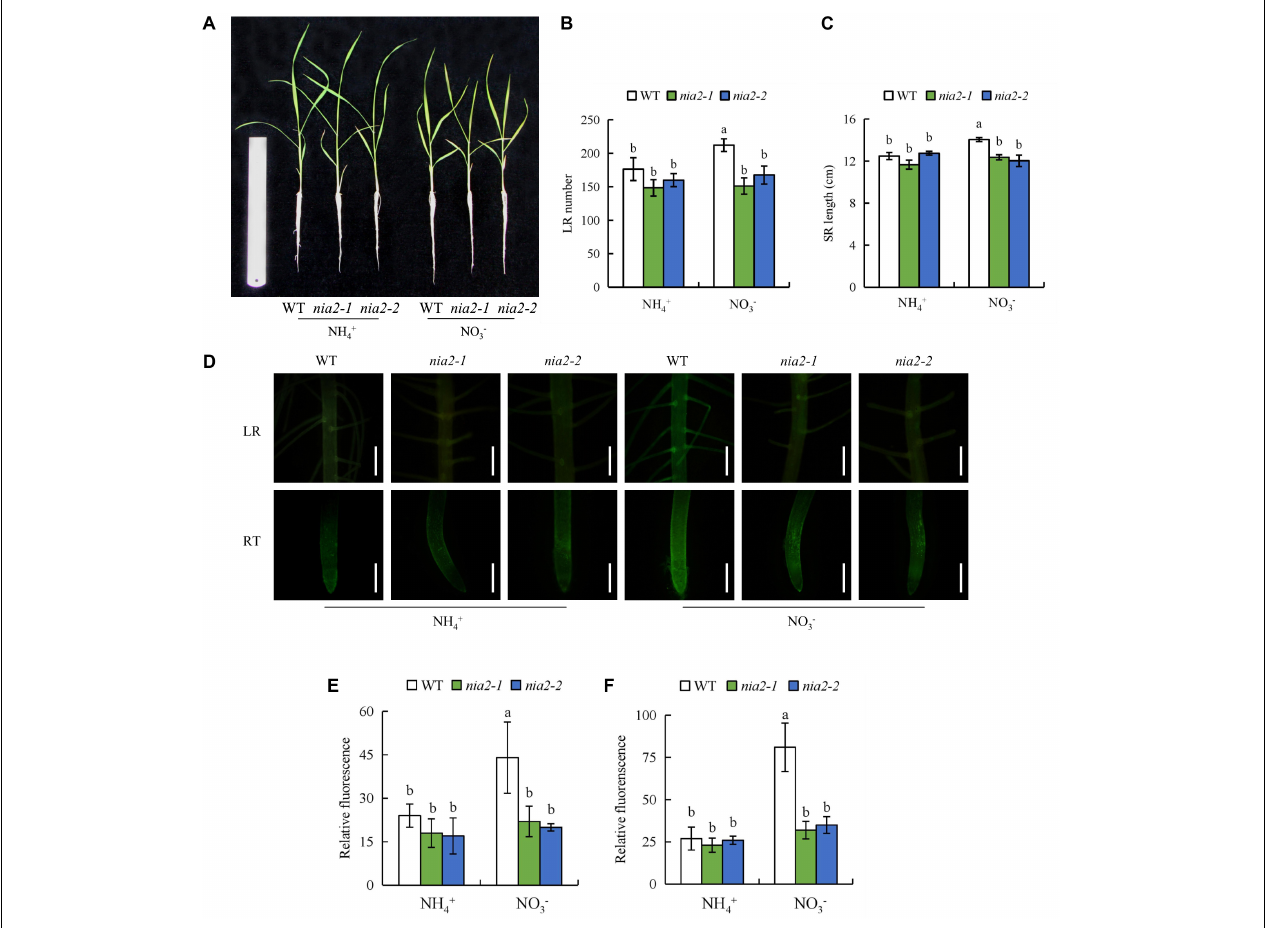
FIGURE 4 | Root morphology and accumulation of nitric oxide (NO) in nia2 mutants and wild-type (DJ) the rice seedlings. Seedlings were grown in hydroponic medium containing NH 4 + and NO 3 − for 14 days. (A) , The morphology of the rice plants; (B) , LR number; (C) , SR length; (D) , Photographs of NO production shown as green fluorescence in the lateral root (LR) and root tip (RT); (E-F), NO production expressed as fluorescence intensity relative to lateral root (E) and root tip (F) . Bar = 1 mm. Data are means ± SE and bars with different letters indicate significant difference at P < 0.05 tested with